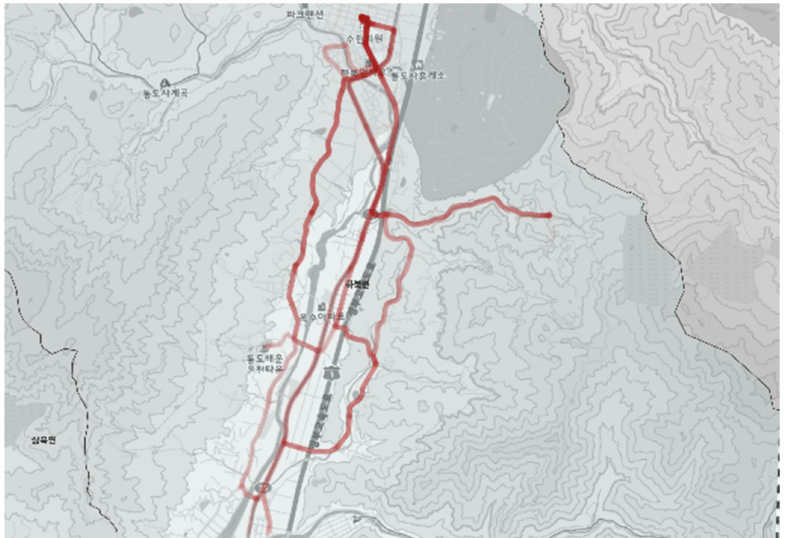
Figure 18. Actual driving record of city-type bus No. 5 (general).